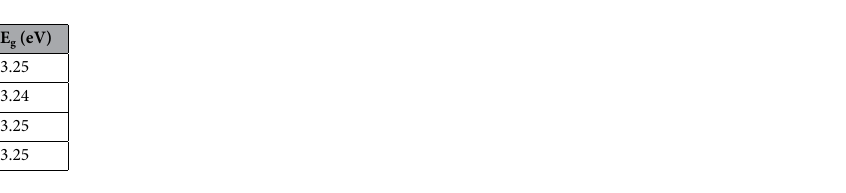
Table 4. Indirect band gap energy values (Kubelka–Munk function, Tauc spectra) from DRS spectra of TiO 2 - A-n% Ag.